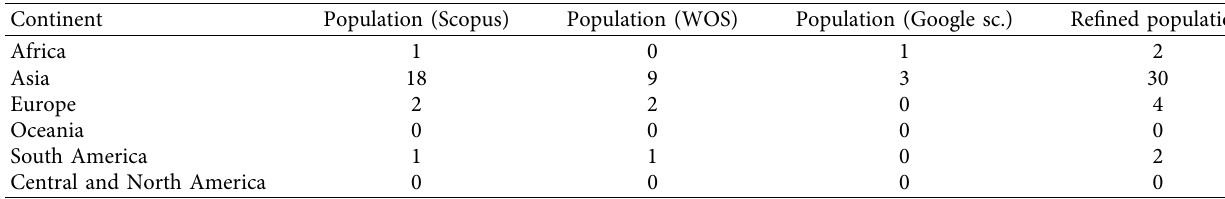
Table 2: Population size for papers related to BIM construction delay.